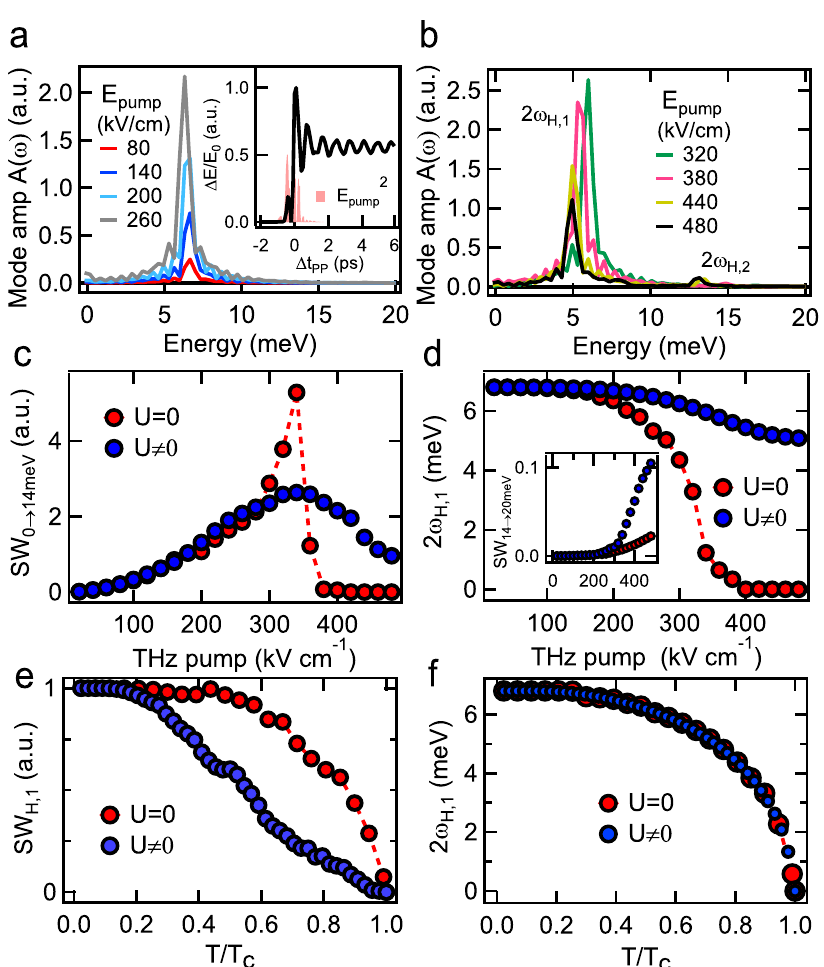
Fig. 4 Gauge-invariant quantum kinetic calculation of the THz-driven hybrid Higgs dynamics. a Calculated Higgs mode spectra for low pump E- fi eld strengths. Inset: Calculated Δ E / E 0 for peak E pump = 380 kV/cm (black) and its comparison with the waveform E 2 (pink, shaded) of the applied THz pump pump pulse in the experiment. b Calculated Higgs mode spectra for higher fi eld strengths show a decrease in amplitude and redshift of the Higgs mode ω ω E fi eld strengths and gets H,1 , consistent with experimentally measured coherent responses in Fig. 3c, d. Note that a second H,2 appears at higher pump - stronger at elevated E pump - fi eld strengths. Although the ω H,2 mode is outside the experimental sampling width, it is revealed by the distinct nonlinear THz fi eld dependence of spectral weight controlled by THz pump (Fig. 3d). c E fi eld dependence of the calculated Higgs mode ω pump - H,1 spectral weight without interband coupling, i.e., U = 0 (red circles) and with strong interband coupling U ≠ 0 (blue circles). d Plot of the Higgs mode frequency 2 ω H,1 as a function of E pump - fi eld strength without interband coupling (red circles) and for strong interband coupling (blue circles). Our simulations for strong U (blue circles) are in full agreement with the experimental results in Fig. 3c-d and in sharp contrast with the one-band SC results obtained for U = 0 (red circles). e , f The calculated spectral weight SW 0 → 14meV e and resonance position f are plotted as a function of temperature for a fi xed pump fi eld of 56.0 kV/cm for U = 0 (red circles) and U ≠ 0 (blue circles). With interband coupling, the SW is strongly suppressed, by about 60% up to a temperature of 0.6 T c , while at the same time the mode frequency is only slightly redshifted, by about 15%, before a full spectral weight depletion is observable towards T c . These simulations are in agreement with the hybrid Higgs behavior in FeSCs and differ from one-band superconductors showing comparable change of SW and position of the Higgs mode with increasing temperature (red